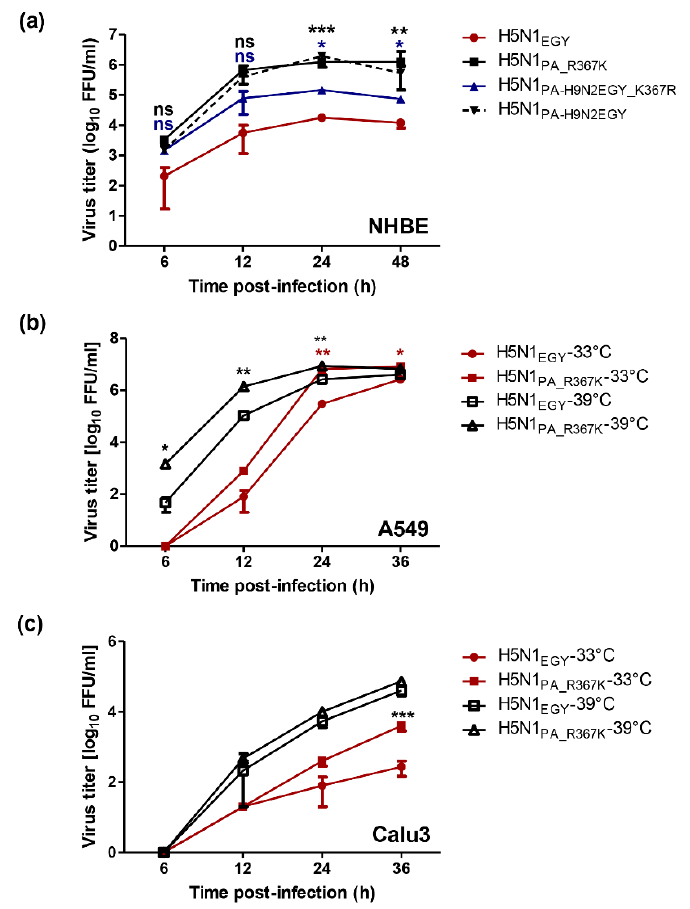
Figure 7. Impact of PA-367K on the replication efficiency of H5N1 EGY in mammalian cell culture models. ( a ) mammalian differentiated primary bronchial epithelial cells (NHBE) cells were infected (in triplicates) with wild-type H5N1 EGY , reassortant H5N1 PA-H9N2EGY , as well as mutant H5N1 PA_R367K and H5N1 PA-H9N2EGY_K367R at MOI of 1, cultured at 37 °C for 6–36 h p.i. ( b ) A549 and ( c ) Calu-3 were infected with wild-type H5N1 EGY and mutant H5N1 PA_R367K (MOI = 0.01) and cultured at 33 °C and 39 °C for 6–36 h p.i. Subsequently the virus titers were determined. Error bars reflect standard deviation